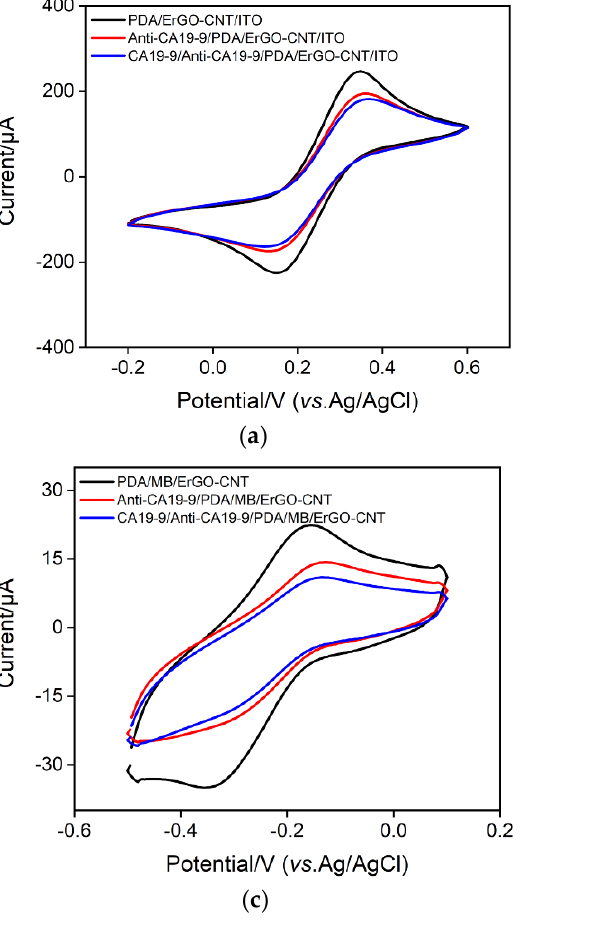
( b ) Figure 8. ( a ) DPV response of the immunosensor to different concentrations of CA19-9, from 0.1 mU/mL to 100 U/mL. ( b ) Calibration curve of the proposed electrochemical immunosensor. Error bars represent the standard deviations of three measurements.